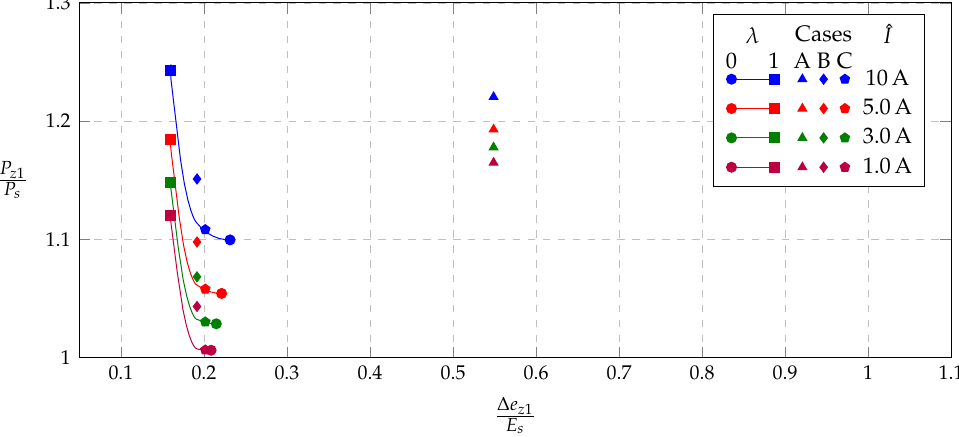
10A,5.0A,3.0A,1.0A ∈ { }